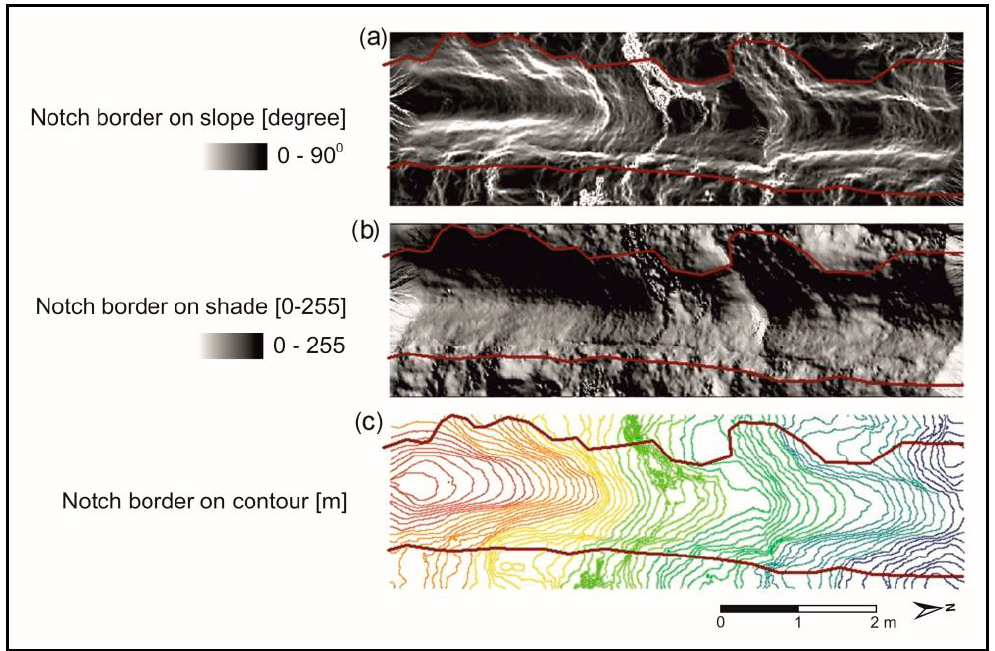
Figure 7. Example of notch boundary identification for notch nb.2. Results based on slope ( a ), hillshade ( b ), and contour data ( c ).